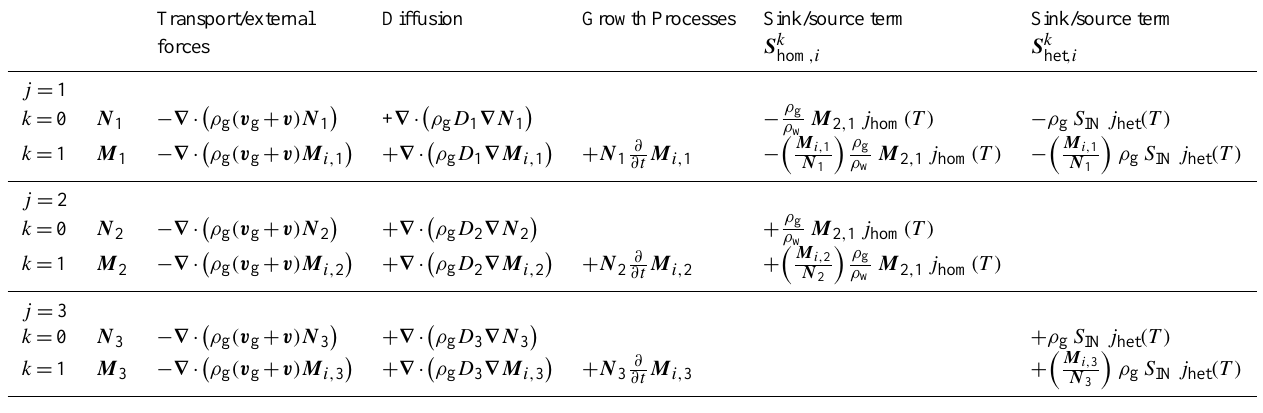
Table 2. Particle dynamics equations, number concentration N ( k = 0) and mass concentration M ( k = 1) in consideration of species i with ammonium sulfate ( i = 1), liquid water ( i = 2), ATD ( i = 3) and ice ( i = 4) for seed particle-droplet mode ( j = 1), homogeneous ( j = 2) and heterogeneous ( j = 3) ice mode.